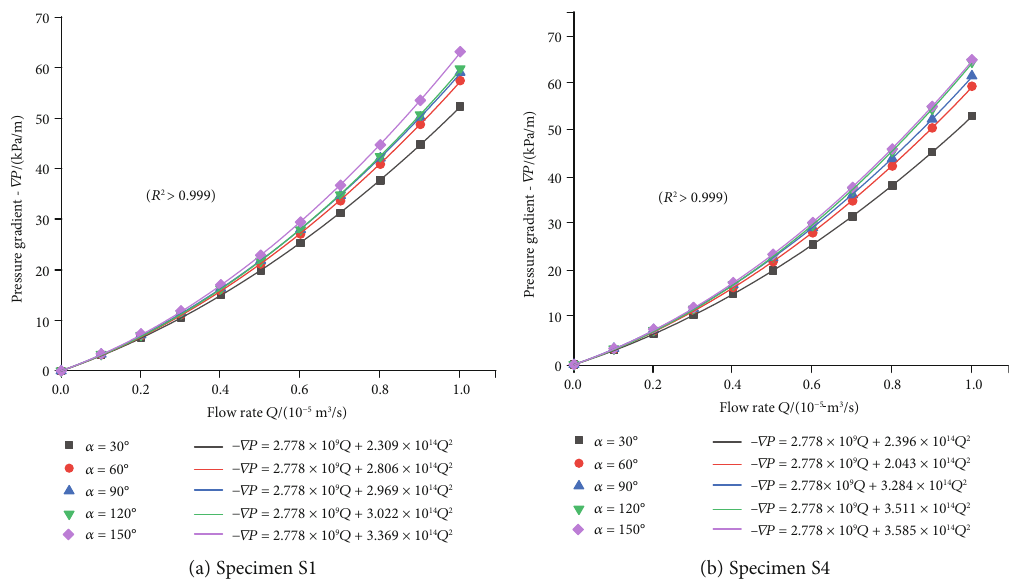
Figure 20: Curves of pressure gradient and fl